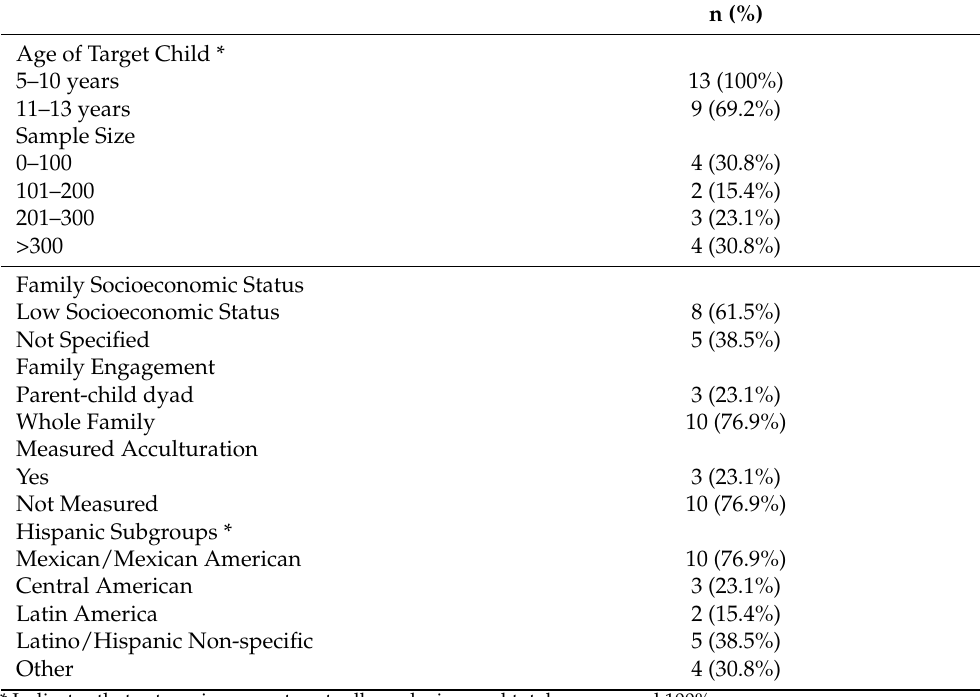
Table 2. Sample characteristics within interventions (n = 13).